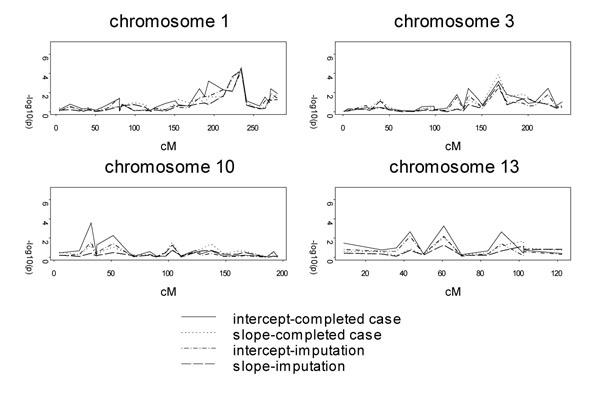
Results of two-point linkage analysis